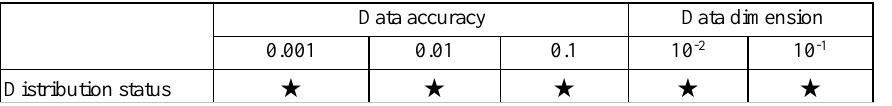
Table 4. Construction based on actual scenario for data